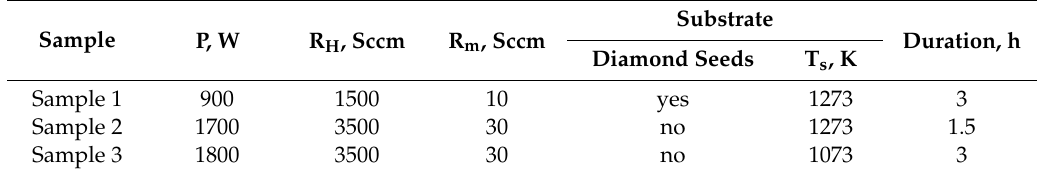
Table 1. Heating power (P), flow rate of hydrogen (R H ) and methane (R m ), substrate temperature (T s ), presence of diamond seeds, and synthesis duration for Samples